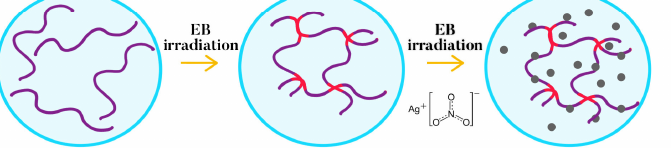
Figure 1. Preparation scheme of antibacterial AgNP-loaded hydrogel sheets by EB irradiation.